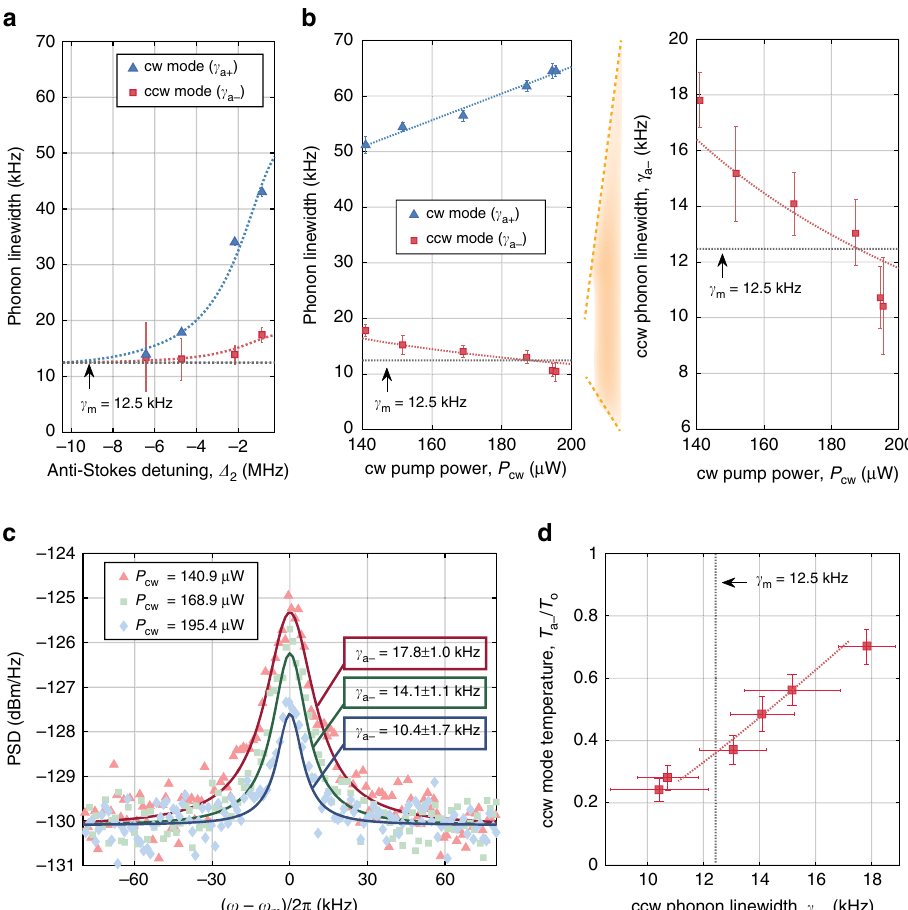
Fig. 4 Chiral refrigeration in a silica whispering-gallery resonator. a Experimental measurement of bare phonon linewidth γ m and observation of chiral asymmetry in dissipation rates for cw and ccw phonons during the initial sideband cooling experiment. Blue and red dashed lines in sub fi gures a and b are fi ts to theory in Supplementary Equation 5. b Observation of increasing ccw phonon coherence during sideband cooling of the cw propagating phonons ( fi xed ccw probe). The ccw phonon linewidth γ a (cid:2) drops below the bare linewidth γ m , indicating reduction in the disorder-induced dissipation. c Measured photocurrent PSD (proportional to ccw phonon PSD) during experiment of sub fi gure b. The ccw phonons experience gain-free spectral narrowing and cooling (reduction in spectrum area) when the cw laser P cw is increased. Solid lines are Lorentzian fi ts to the data. d Measured ccw phonon mode temperature T eff a vs linewidth γ a (cid:2) showing that, in contrast to sideband cooling, both the linewidth and temperature decrease during this experiment. (cid:2) Temperature is calculated using the integrated phonon power spectrum (examples in sub fi gure c ), with vertical error bars generated from amplitude uncertainty. Red dashed line is a fi t to the theory of equations (2) and (3). The phonon mode starts pre-cooled due to the sideband cooling from the probe. All error bars correspond to 95% con fi dence intervals for their